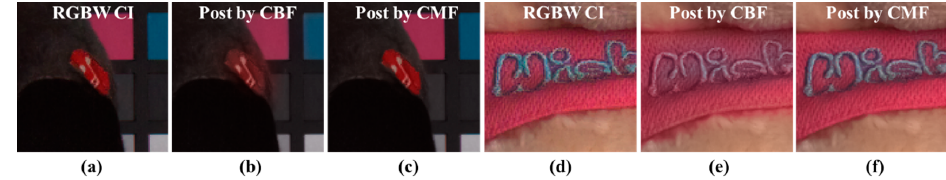
Figure 10. Results of post-processing using CBF and CMF; ( a , d ) Sony RGBW CFA demosaicing results [24]; ( b , e ) results of post-processing using CBF; ( c , f ) results of post-processing using CMF.